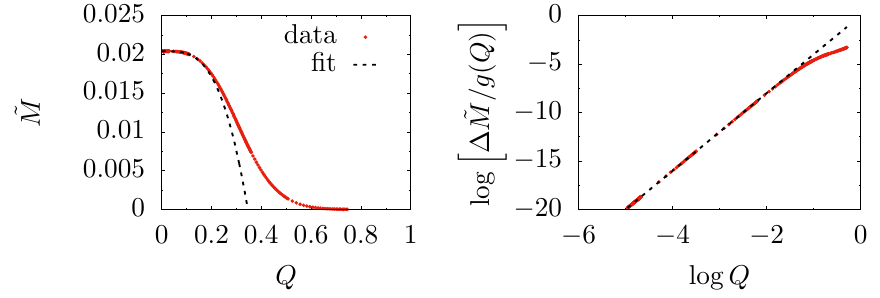
Figure 3 . Scaling of mass. We show the rescaled mass ~ M as a function of the normalized proper distance between the poles Q = L A =L (left). To illustrate the remarkable agreement of data points and (cid:12)t, we plot the mass di(cid:11)erence (cid:1) ~ M = ~ M 0 a double logarithmic diagram